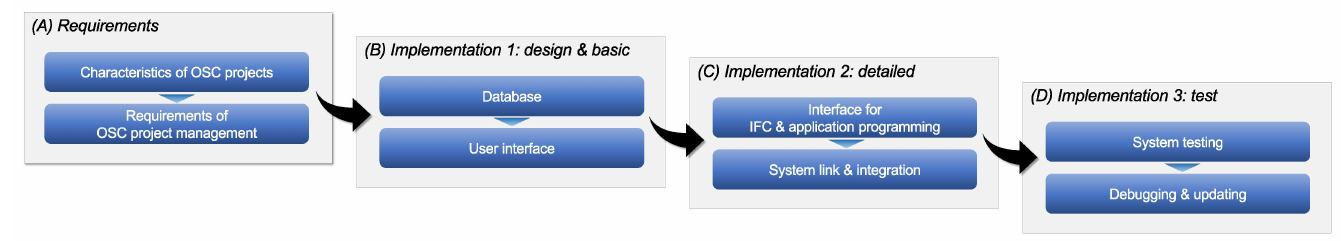
Figure 1. System development